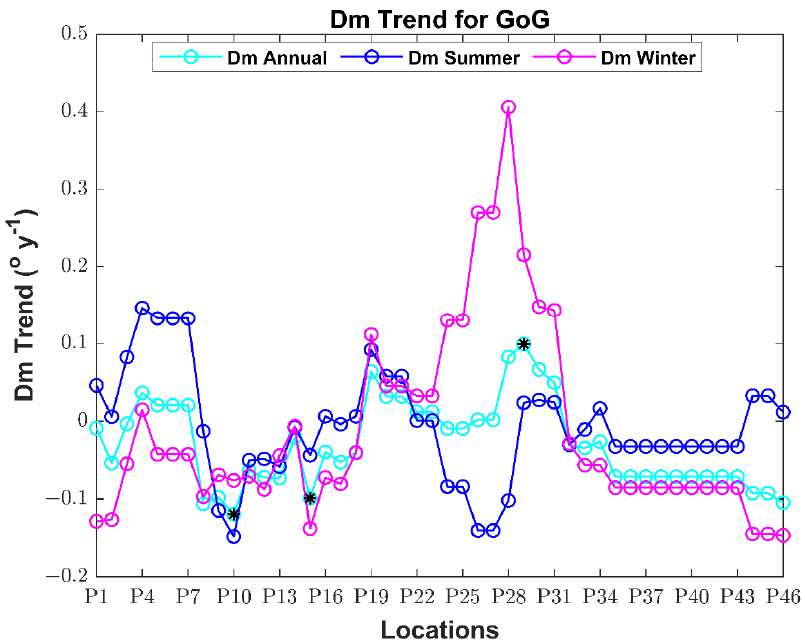
Figure 7. Line plot of the annual, winter, and summer trends of Dm with asterisk showing locations with a significant trend. Asterisk (*) represents significant Dm trend. The spatial variation of the trend values showed a high seasonal fluctuation in the wave direction in the coastal areas of the Benin Republic and Togo between P24 – P28. This is evident in values recorded for the summer and winter trends in Figure 7 where Dm in the summer and winter show opposite signs. The summer Dm trends decrease at rates ranging from 8.4 × 10 −2 – 14 × 10 −2 degrees per year while the reverse is the case during the winter with Dm increasing at rates between 13 × 10 −2 – 41 × 10 −2 degree per year. Neverthe- less, the annual average in this region is shifting into a more southwesterly orientation (and moving in a northeast direction towards the coast. The summer showed a high rate of clockwise (westerly) shift while the winter showed more waves becoming increasingly southerly (anticlockwise shift). Another region with different signs of Dm is seen in Gabon (P44 – P46) where the Dm is reducing into becoming more southerly in the winter at rates ranging from 14 × 10 −2 degree per year. This changed to increase with a more southwest- erly wave in the summer with values up to 3.3 × 10 −2 degree per year. These inter-seasonal variabilities will impact the sediment drift in this coastal area and need to be monitored for erosion and accretion hotspots. Apart from the southernmost part of the GoG around Gabon, most points in the northwestern part showed a decrease in wave direction (clock- wise shift) throughout the year. This majority decrease contributed to the negative aver- age value reported in Table 4 though a closer observation of the values from one location to another showed some spatial variations. This spatial variation in wave direction trend can be observed in places such as P1 – P7 and P18 – P23 in addition to the other two regions around the Benin Republic and Gabon. This observation emphasizes the need for a loca- tion-based analysis of wave climate in these regions rather than extrapolating the regional wave condition in the GoG for every country in the region. The need for this aforementioned location-based further analysis of wave conditions is readily explainable when one compares the trend values for some locations with the average regional values presented in Table 4. For example, the regional average Dm trend